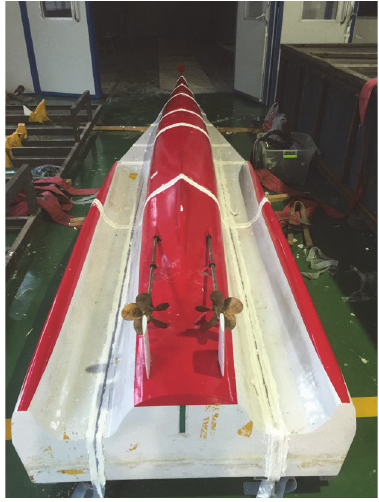
Figure 2: Trimaran model shell.